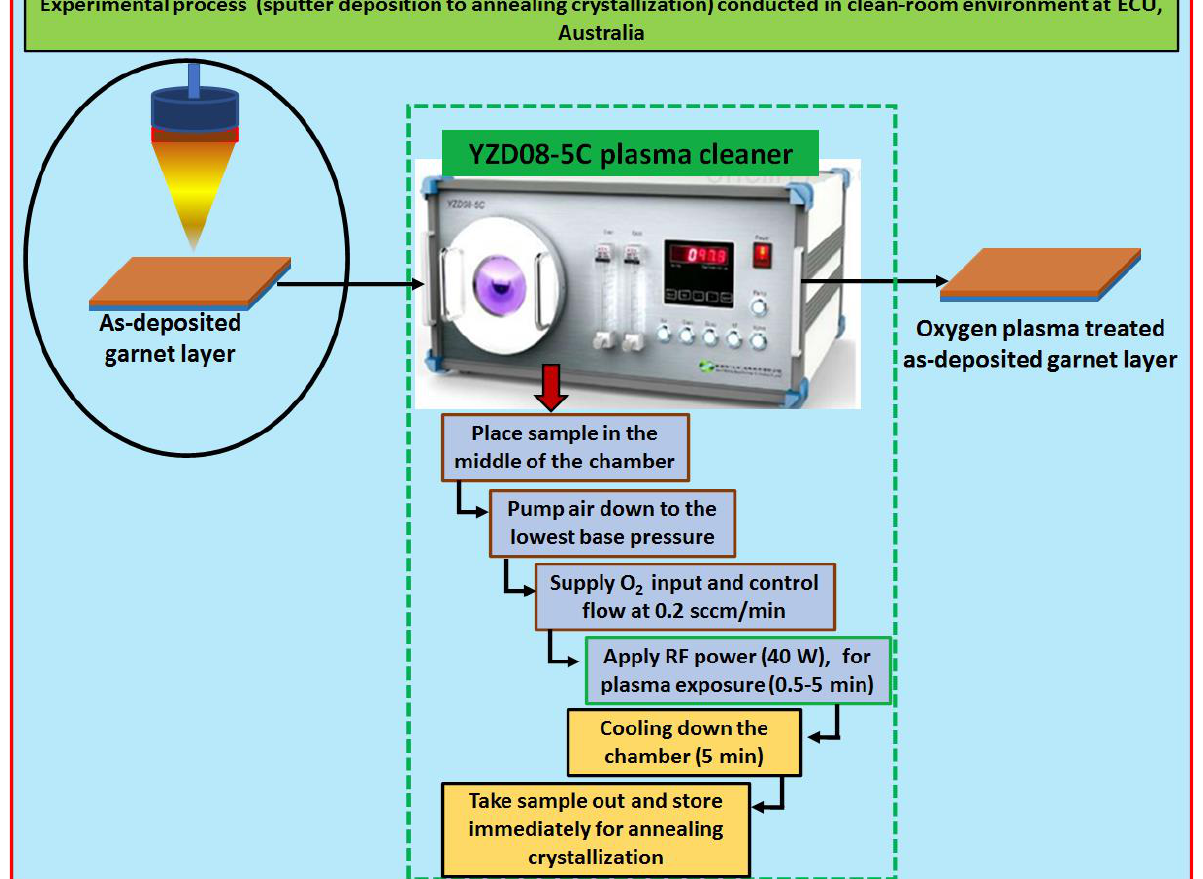
Figure 4. Schematic diagram of the flow chart of oxygen plasma treatment process applied to as-deposited garnet layers.